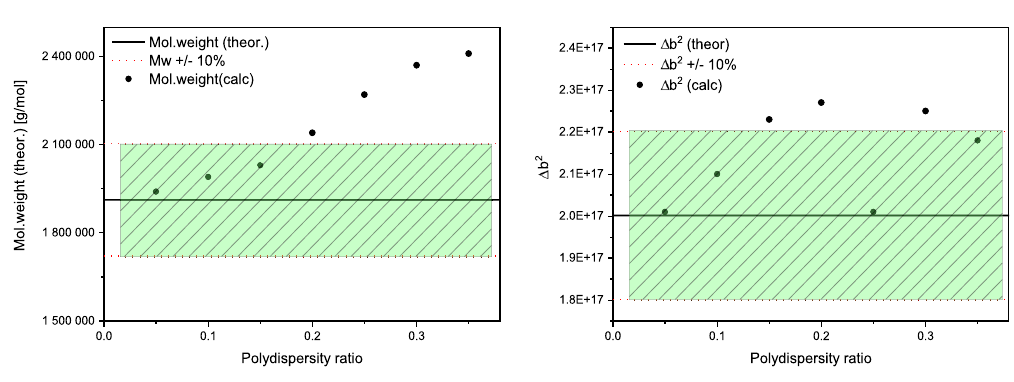
Figure 4. Acceptable accuracy window for the determination of M w and Δb 2